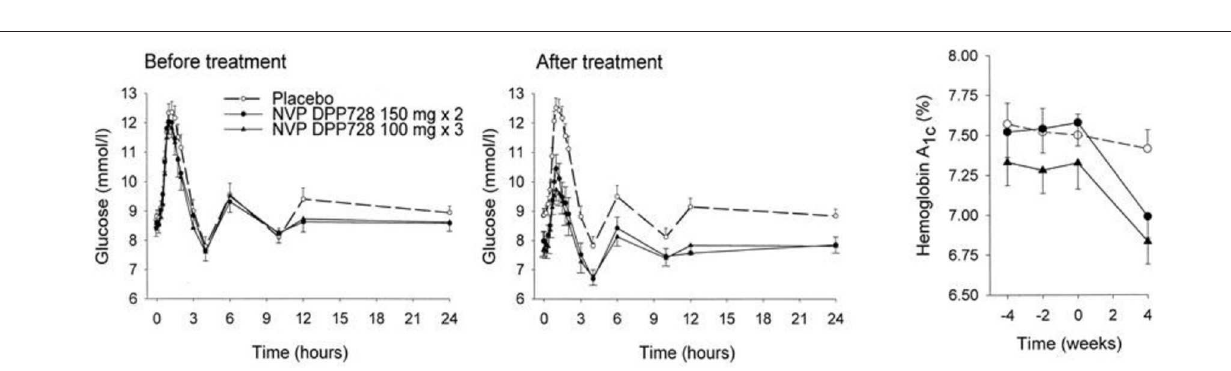
FIGURE 3 | Twenty-four-hours glucose levels and HbA1c before and after 4 weeks of treatment with placebo ( n = 32) or the DPP-4 inhibitor NVP DPP728 at 100mg three times daily ( n = 30) or 150mg twice daily ( n = 30) in subjects with drug-naïve type 2 diabetes. Means ± SEM are shown. NVP DPP728 significantly reduced glucose levels and HbA1c at both doses compared to placebo. Data from Ahrén et al. ( 49). Reprinted with permission from the American Diabetes